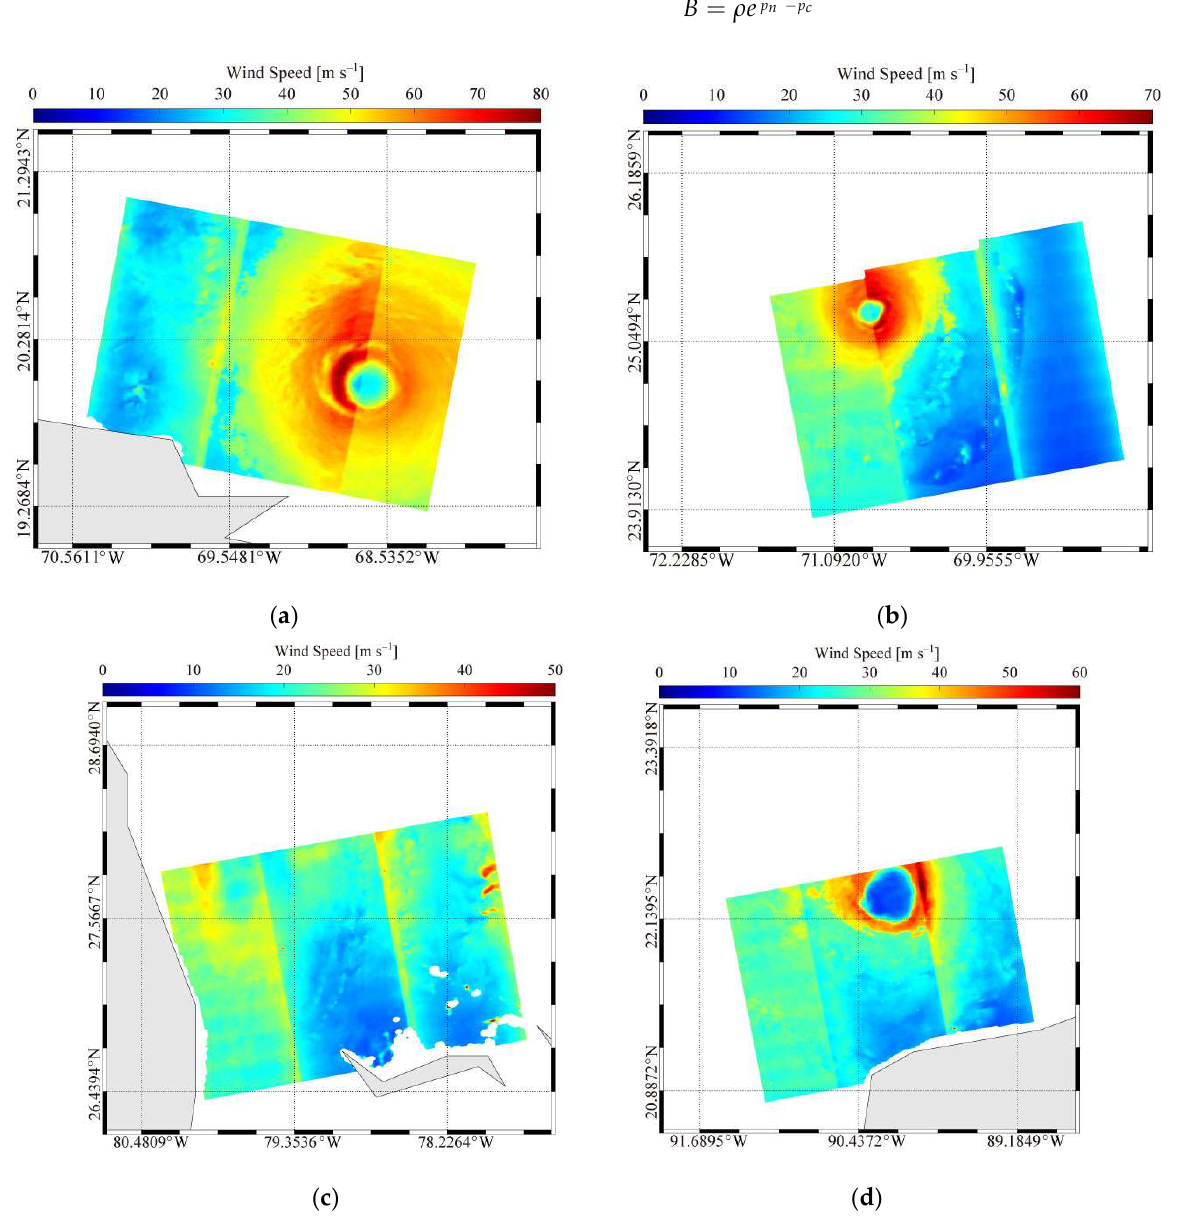
Figure 3. Inverted wind maps derived from of VH-polarized S-1 SAR images using the S1IW.NR GMF. ( a d ) The SAR scenes shown in Figure 1a–d.